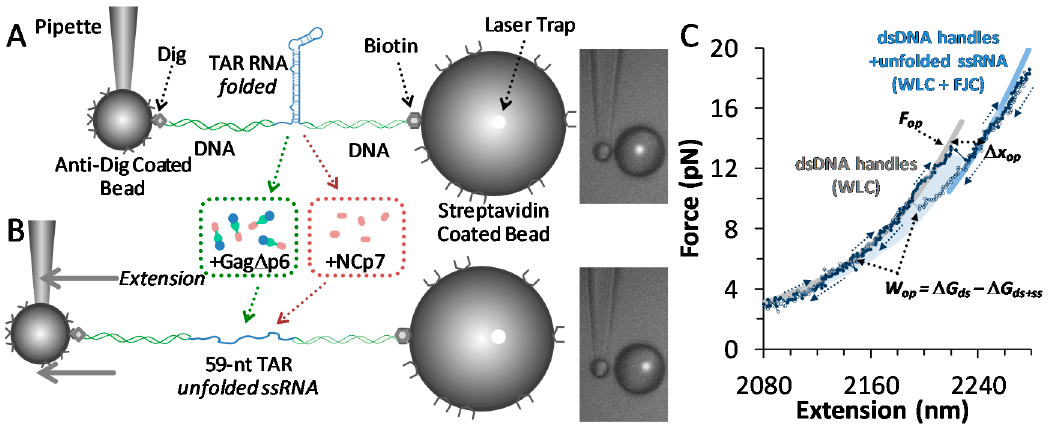
Figure 2. Single molecule assay observes hairpin opening and folding. ( A ) Single molecule construct of a TAR RNA hairpin (blue) flanked by long, labeled dsDNA handles (green), suspended between functionalized beads. The anti-dig-coated bead (2.1 µ m diameter) was fixed onto a glass micropipette, while the streptavidin-coated bead (3.1 and 5.4 µ m diameter beads were used) was held in a dual-beam optical trap. ( B ) Stepwise increases in extension raise the tension until a critical force is reached and the hairpin is completely disrupted, leaving ssRNA. ( C ) Three cycles of increasing force extension (along the arrows, filled circles) and force release (open circles decreasing along the arrows) reveal this length change ( ∆ x op ), the force ( F op ) and the work done by the instrument in hairpin unfolding ( W op ). Models of polymer elasticity are shown and are described in Appendix A. Experimental bu ff ers included 10 mM HEPES (pH 7.5) and 100 mM Na + , unless noted. Results were compared to experiments performed in saturating conditions of Gag ∆ p6 and